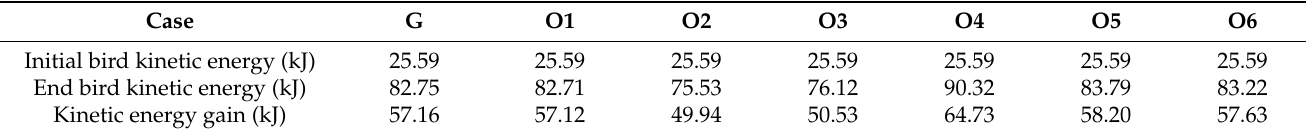
Table 6. The change in the kinetic energy of the bird for different bird impact